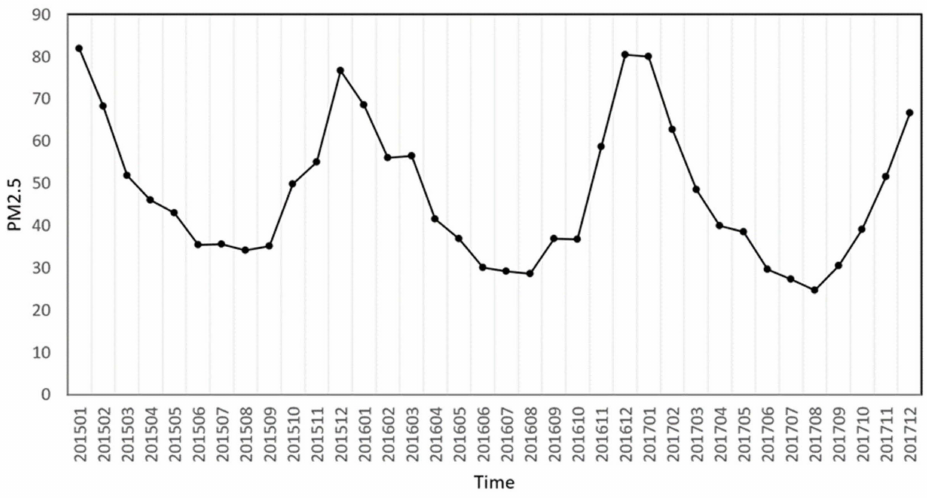
Figure 4. Monthly average of PM2.5 levels in China from 2015 to 2017.